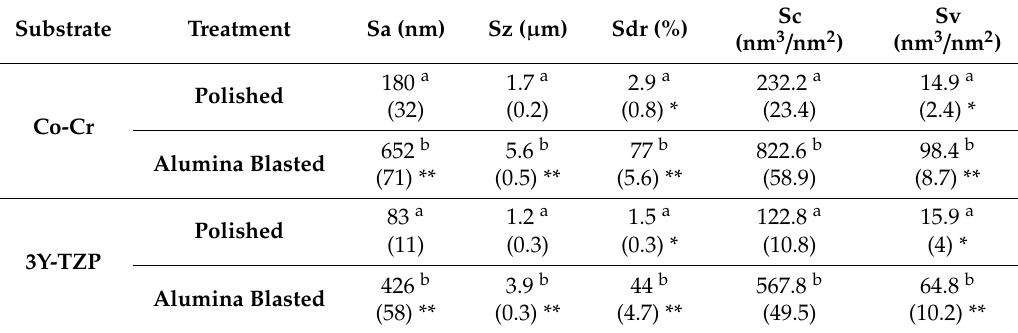
Figure 2. 3D-profilometric images of polished and alumina-blasted surfaces of the Co-Cr alloy and 3Y-TZP. Note di ff erences in the z scale bar ranges (40 × magnification). Table 2. The means and standard deviations of the roughness parameters tested. Same superscript letters show values with no statistically significant di ff erence within each treatment group per parameter ( t -test, p > 0.05). Asterisks denote the Co-Cr (*) and 3Y-TZP (**) pairs where non-parametric analysis was performed (Mann–Whitney